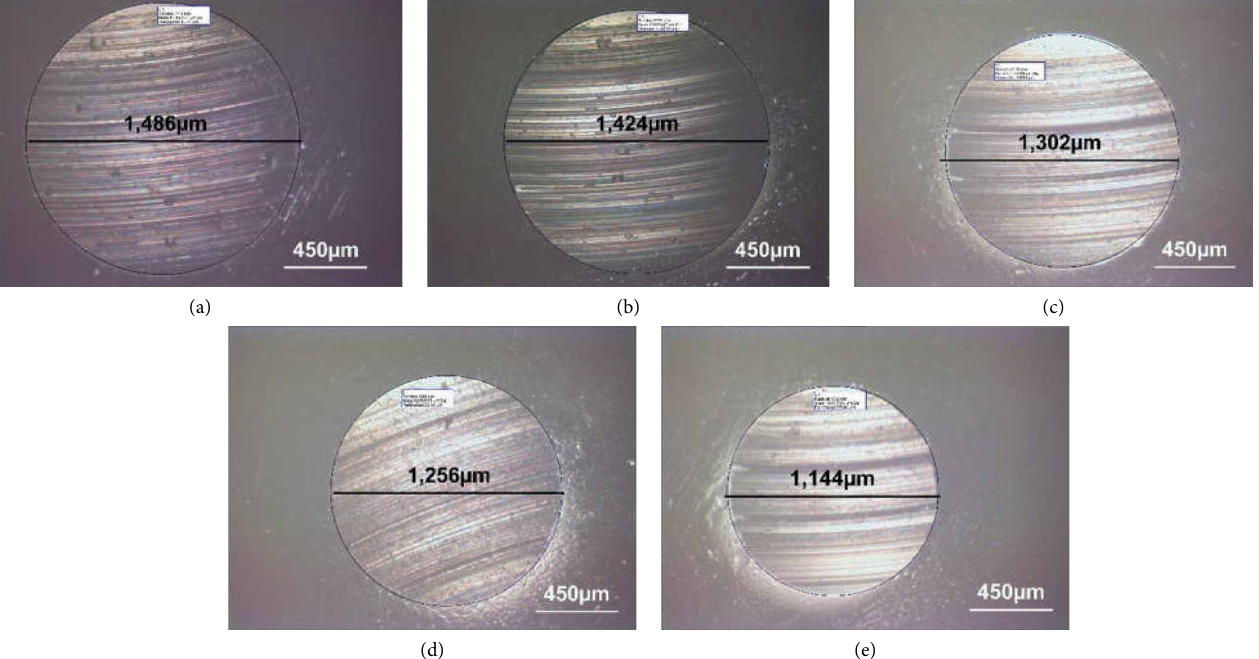
Figure 8: Optical micrographs of wear scar diameter: (a) pure neem oil, (b) 0.25% GNPs-NO, (c) 0.50% GNPs-NO, (d) 0.75% GNPs-NO, and (e) 1.0% GNPs-NO.